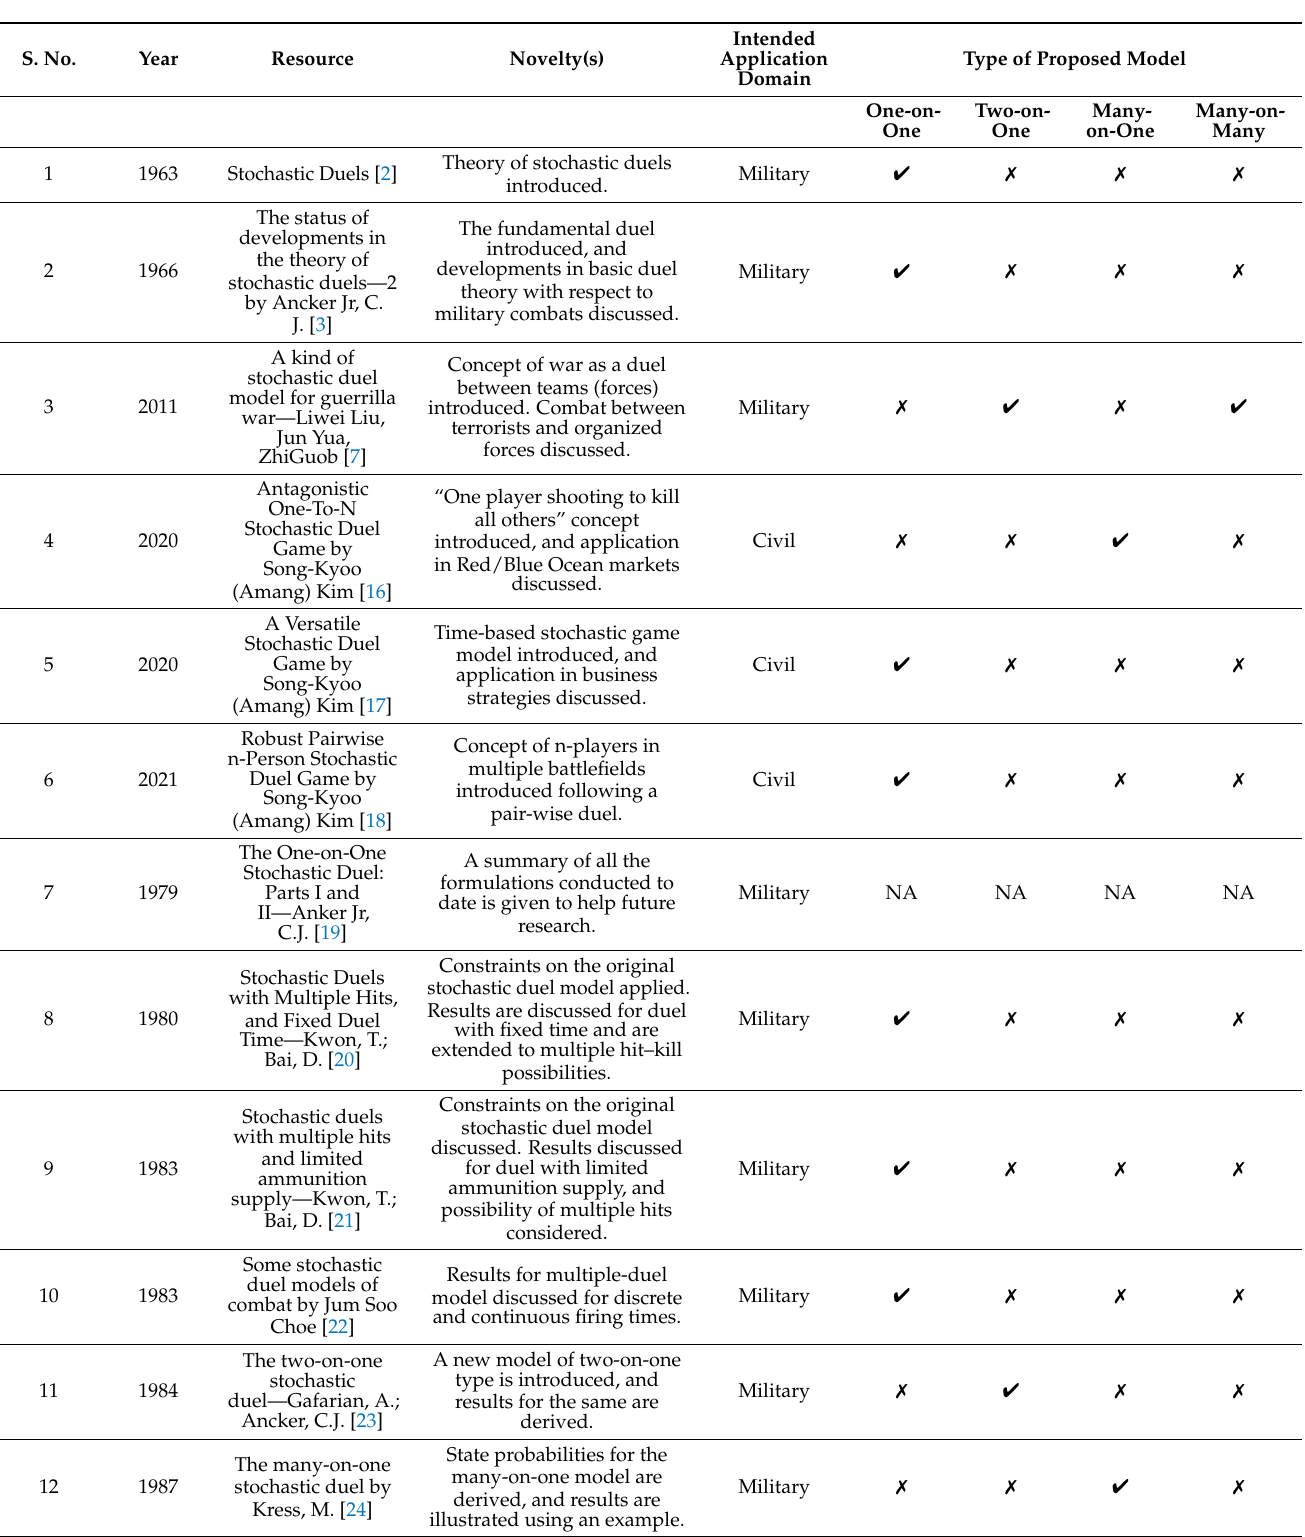
Table 1. Variations introduced in the stochastic duel game model over